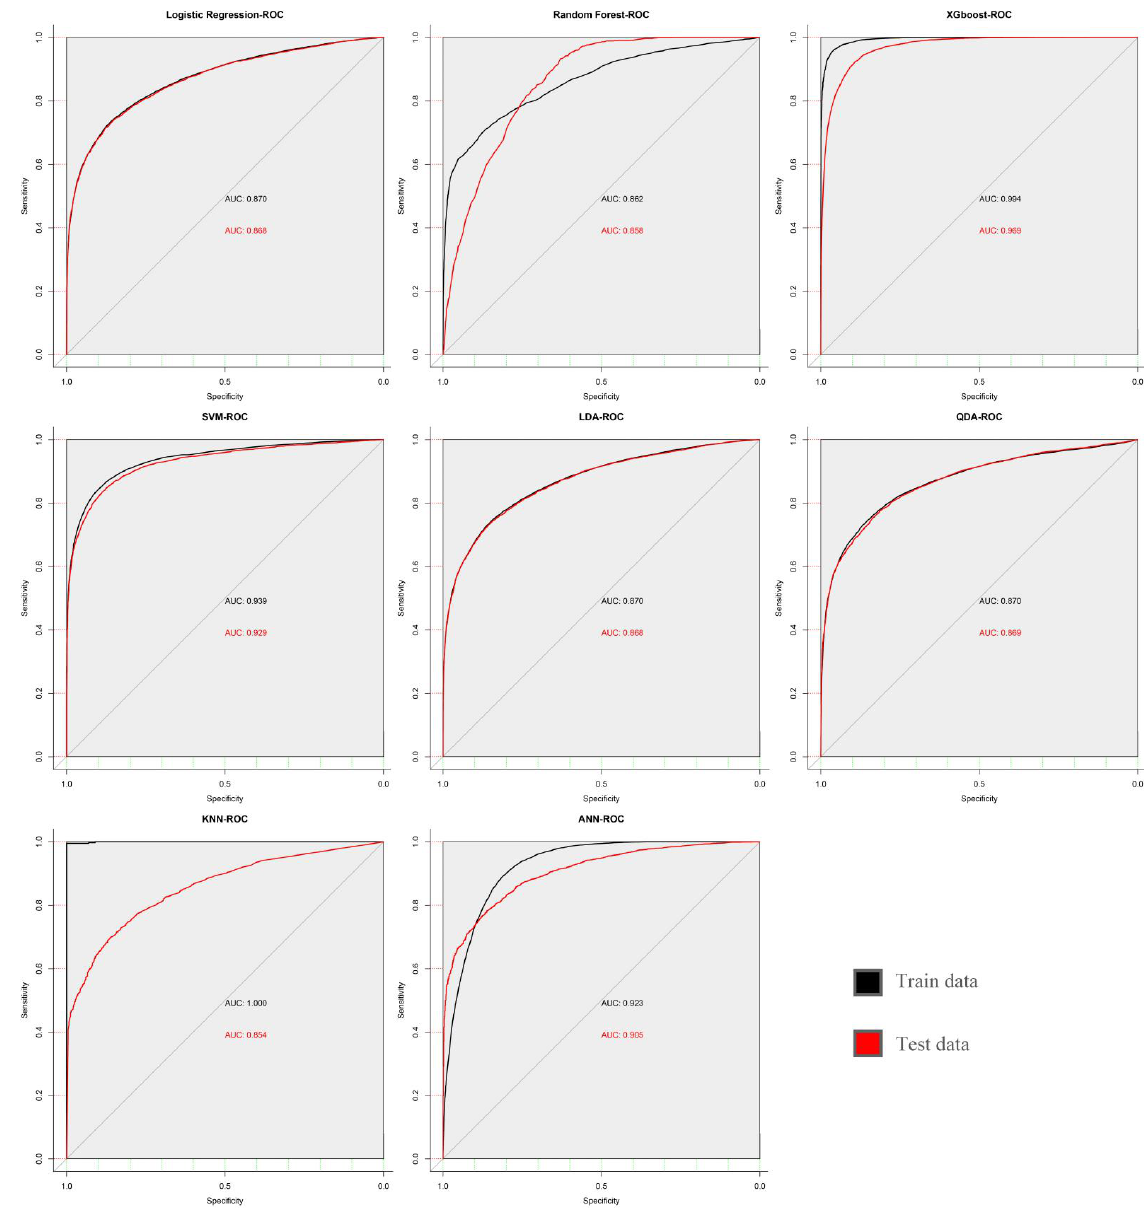
Figure 2. Receiver operating characteristic curve of all machine learning models.